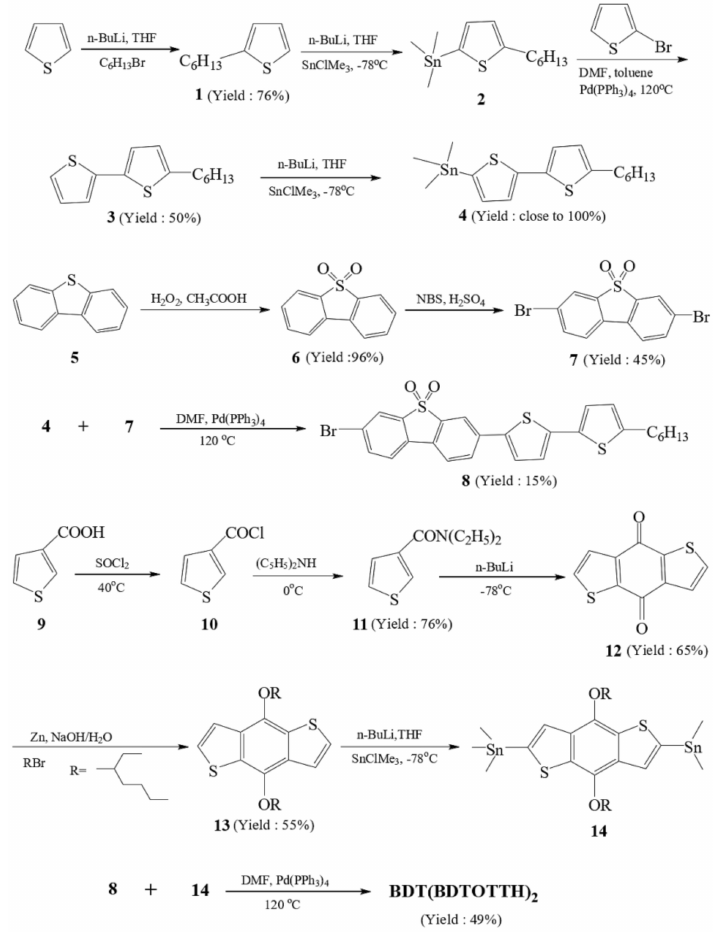
Figure 2. Synthetic pathway for the oligomer BDT(DBTOTTH) 2